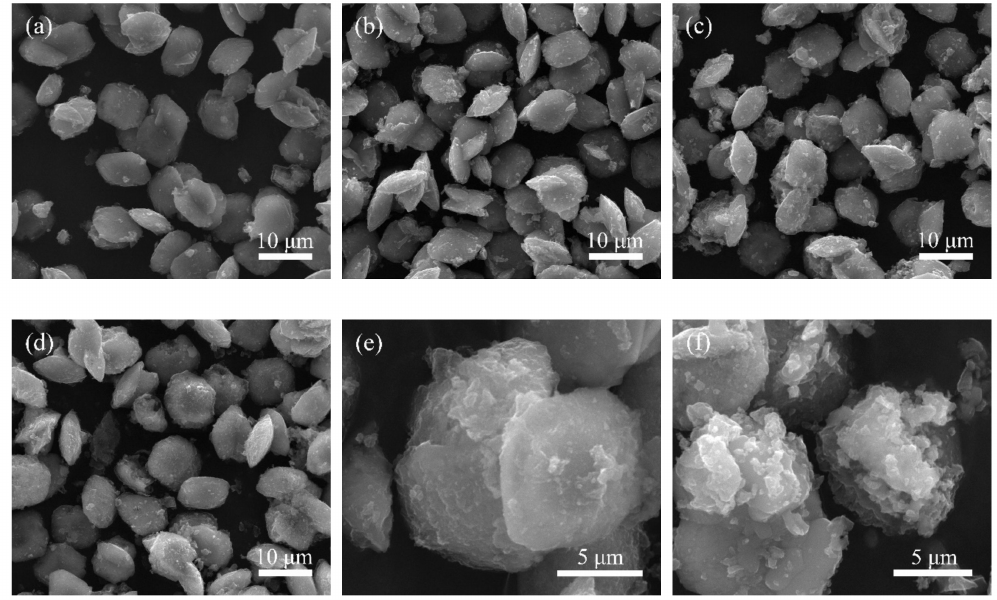
Figure 10. SEM images of the solid samples from washing natisite with water and sulfuric acid solutions. ( a – f ) represent the samples W2, W3, W4, A2, A3 and A4,